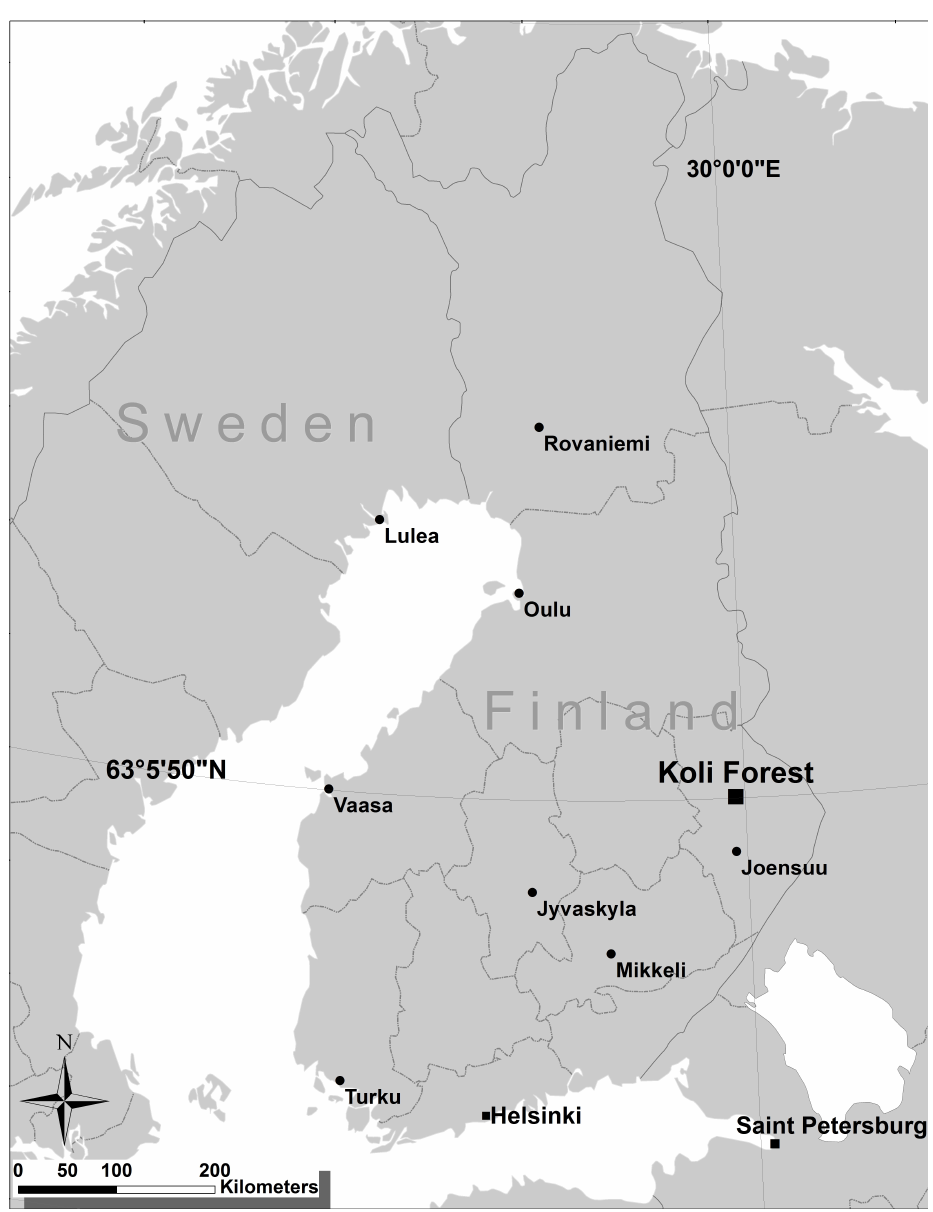
Figure 1. Map of Finland showing the location of the study